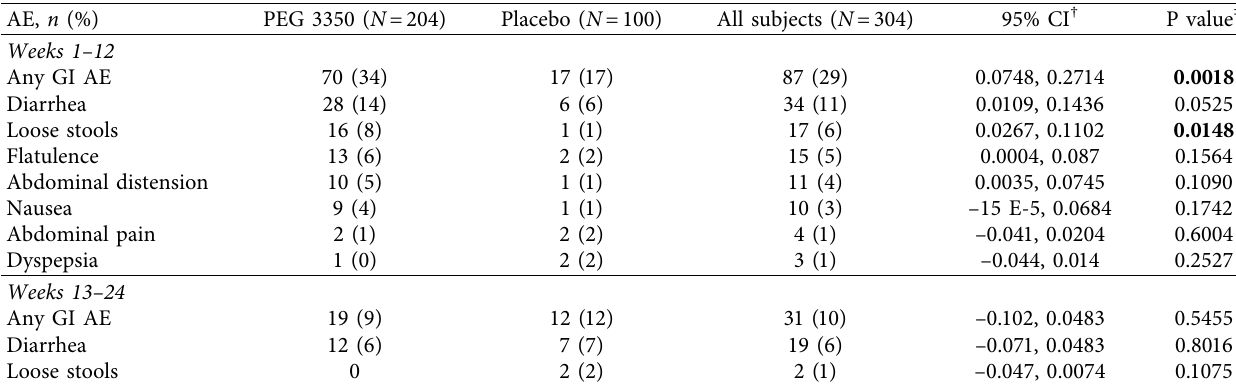
Figure 3: Mean change in the number of BMs associated with straining (a), hard/lumpy stools (b), cramping (c), and gas (d) over time. Abbreviations: BM, bowel movement; PEG, polyethylene glycol. † P < 0 . 05. Baseline is defined as the average of 2 weeks before treatment (i.e., weeks − 2 and − 1). Analysis based on available non-missing values in each week. P value derived from the analysis of variance with treatment, pooled-site, and their interaction as covariates. Table 3: Gastrointestinal AEs ( ≥ 2% in any treatment group) during weeks 1 through 12 and weeks 13 through